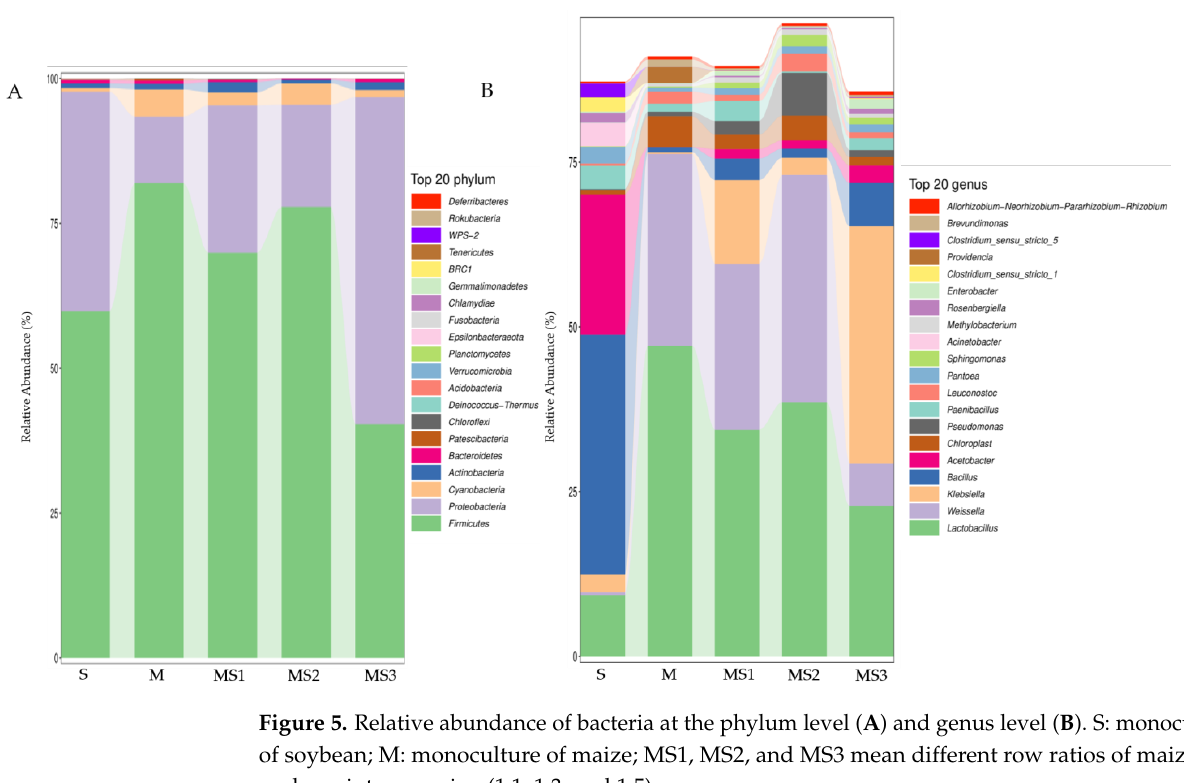
Figure 4. Unweighted UniFrac PCoA plot of the five silage treatments. S: monoculture of soybean; M: monoculture of maize; MS1, MS2, and MS3 mean different row ratio of maize and soybean in- tercropping (1:1, 1:3 and 1:5).